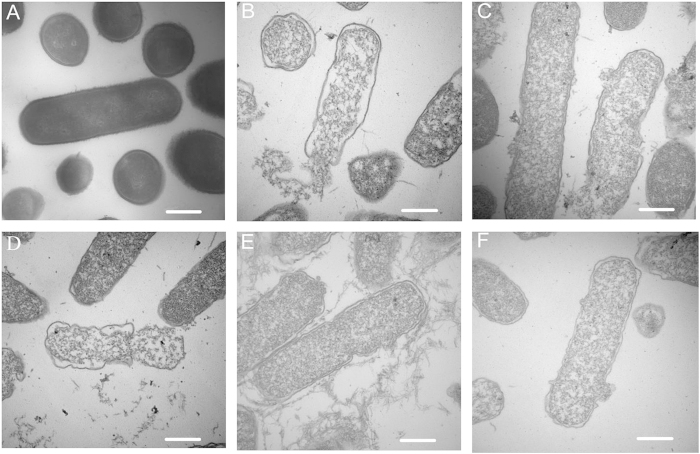
TEM micrographs of E. coli ATCC 25922: (A) Control; (B) GG2-treated; (C) GG3-treated; (D) AA2-treated; (E) AA3-treated; (F) Melittin-treated. Bacteria were treated with centrosymmetric peptides at 1 × MBC for 1 h. The control was processed without centrosymmetric peptides. Scale bar = 500 nm.